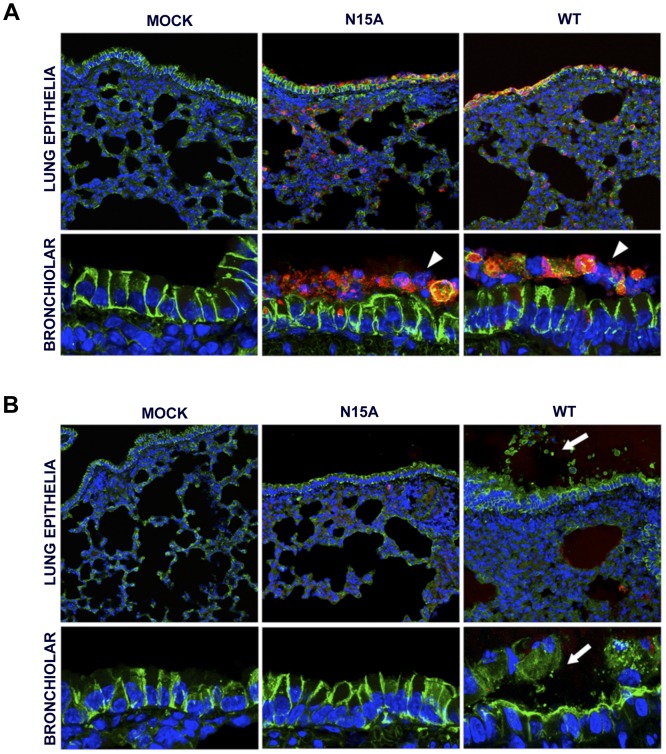
Lung epithelia disassembly in SARS-CoV infected BALB/c mice.16 week-old BALB/c mice were mock infected (Mock) or infected with 100000 PFU of the parental virus (wt) displaying E protein IC activity or the mutant virus lacking IC activity N15A. At 2 (A) and 4 (B) dpi mice were sacrificed and their lungs were fixed in formalin, paraffin embedded, sectioned and processed for immunofluorescence. Na+/K+ ATPase was labeled in green, SARS-CoV N protein was labeled in red to detect infected cells and cell nuclei are shown in blue. A general view of lung epithelia at an original magnification of 40× is shown in the upper rows of the panels. Magnified bronchiolar epithelia at an original magnification of 189× are shown in the rows of the bottom. White arrowheads indicate cell desquamation in the bronchiolar barrier. White arrows show epithelium disassembly and mislocated Na+/K+ ATPase staining away from basolateral cell membranes, and present within air spaces.